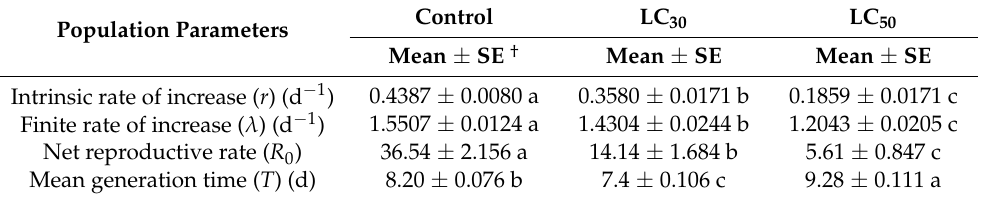
Table 3. Mean value ( ± SE) of fertility parameters of Aphis glycines exposed to acetamiprid. Population